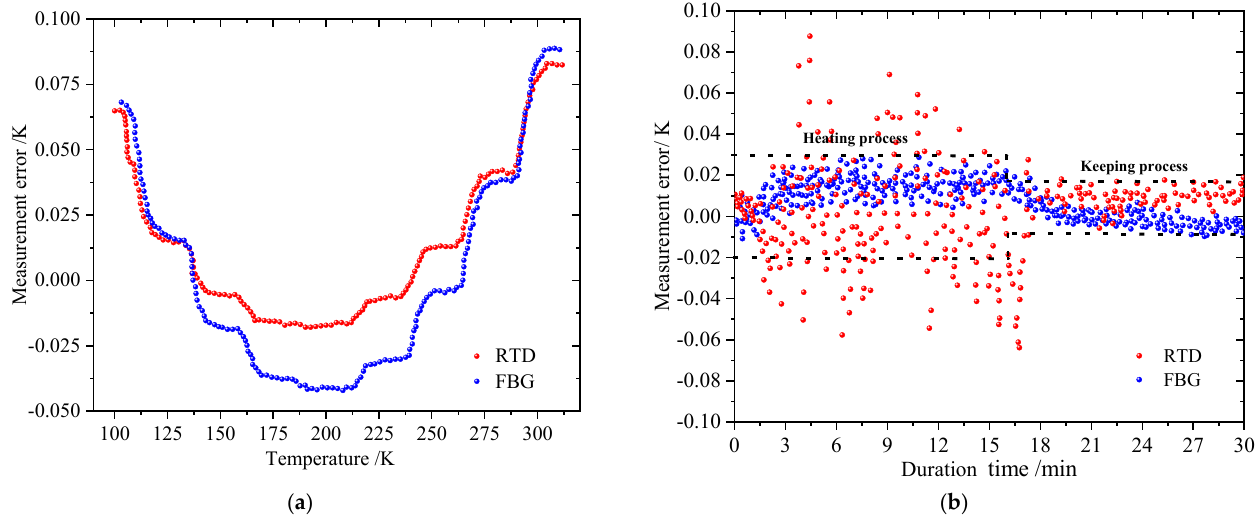
Figure 7. Measurement results of RTD and FBG: ( a ) comparison of measurement accuracy; ( b ) comparison of measurement stability.